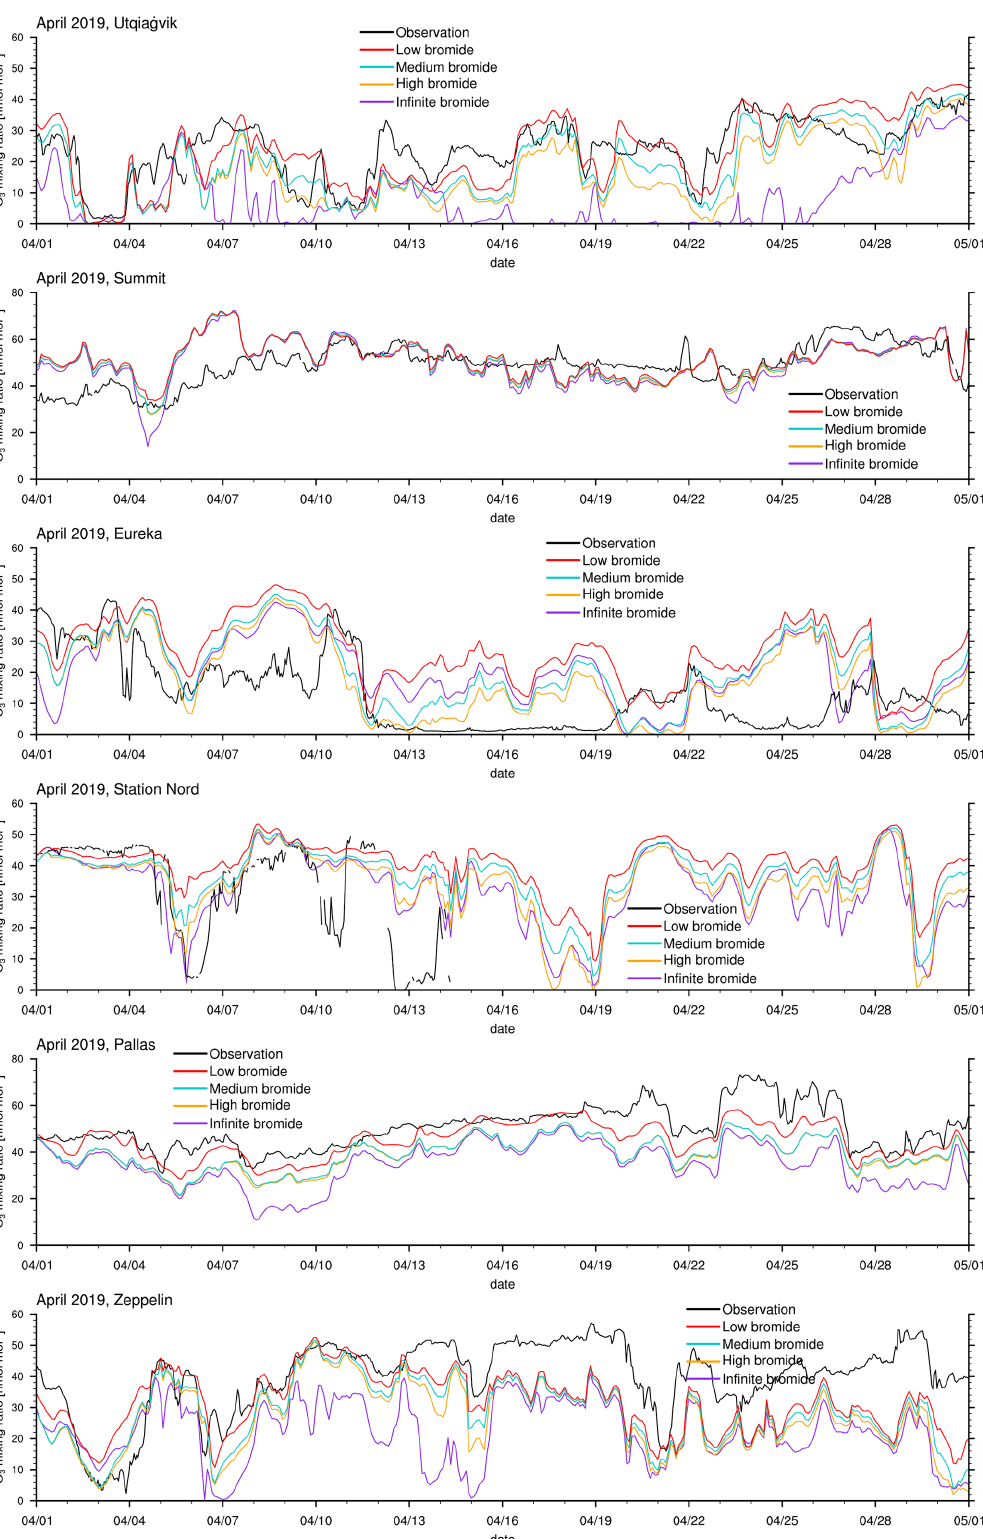
https://doi.org/10.5194/acp-22-13495-2022 Atmos. Chem. Phys., 22, 13495–13526,